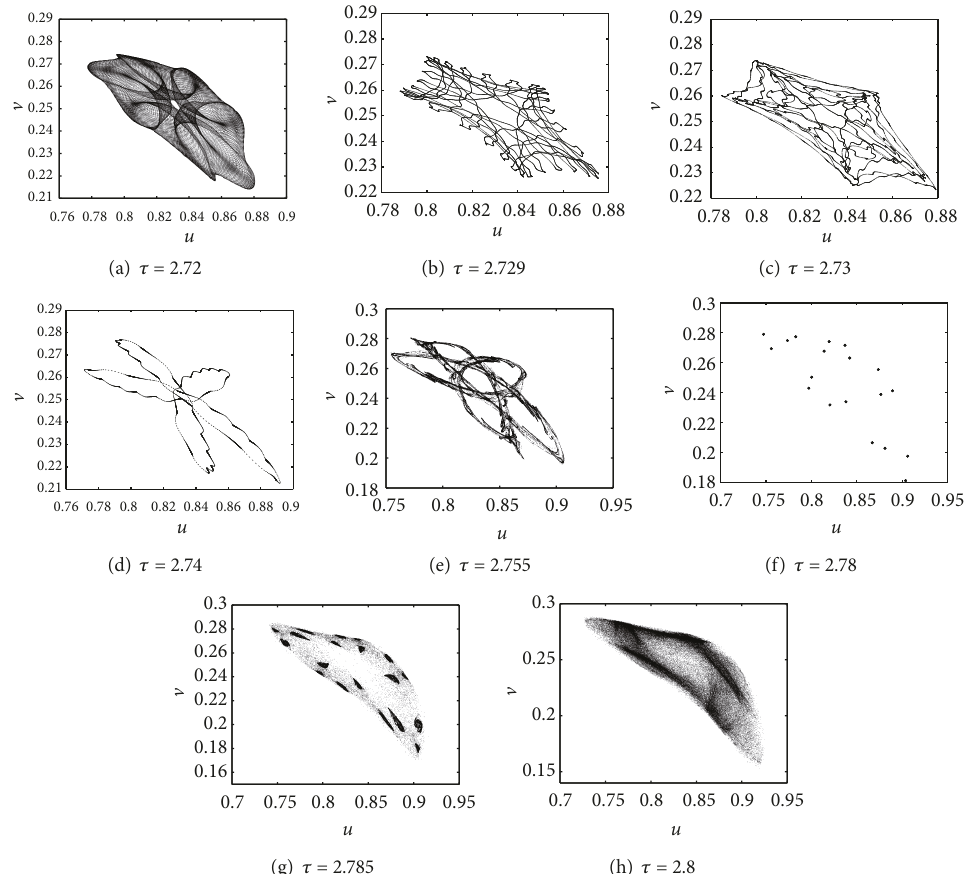
Figure 13: Phase diagrams for different values of parameter 𝜏 corresponding to Figure 11(c), demonstrating the predator-prey dynamics at one node of the coupled network.